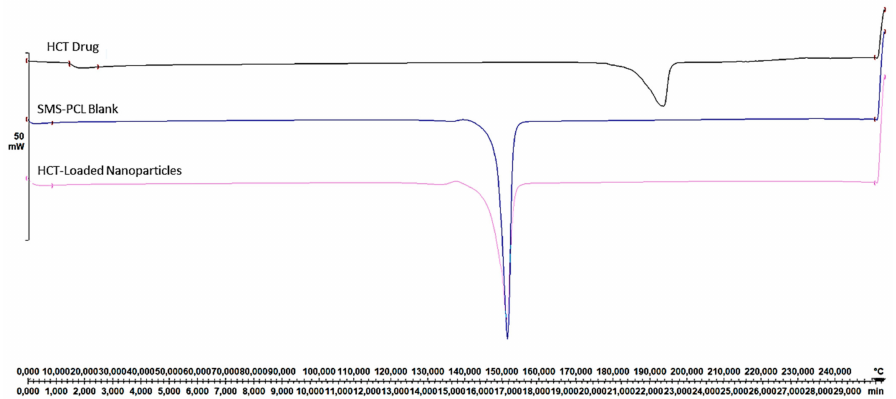
Figure 5. DSC of HCT, SMS-PCL blank, and HCT-loaded nanoparticles.